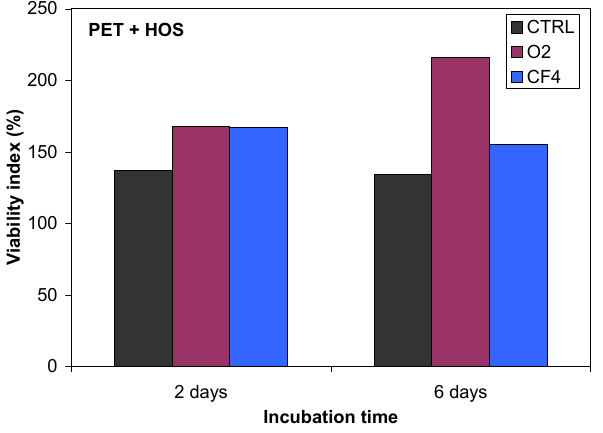
Figure 16. Proliferation of HOS cells on untreated and plasma-treated PET polymers, as measured using an MTT